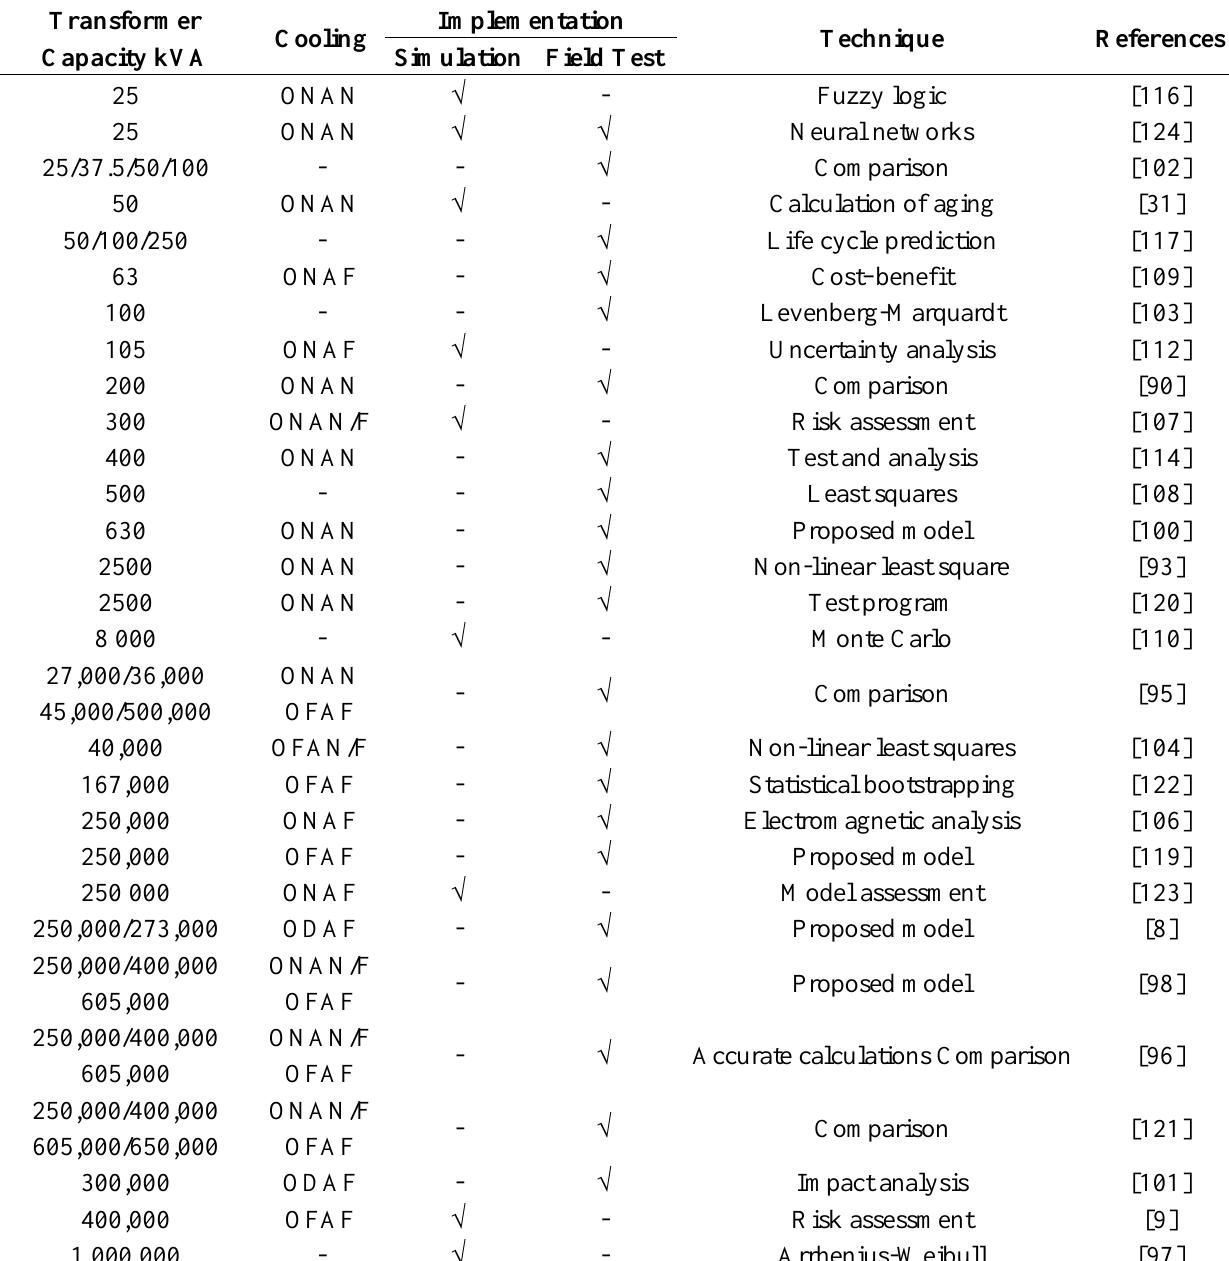
Table 6. Transformers on which the ageing is influenced by unspecified experimental loads.